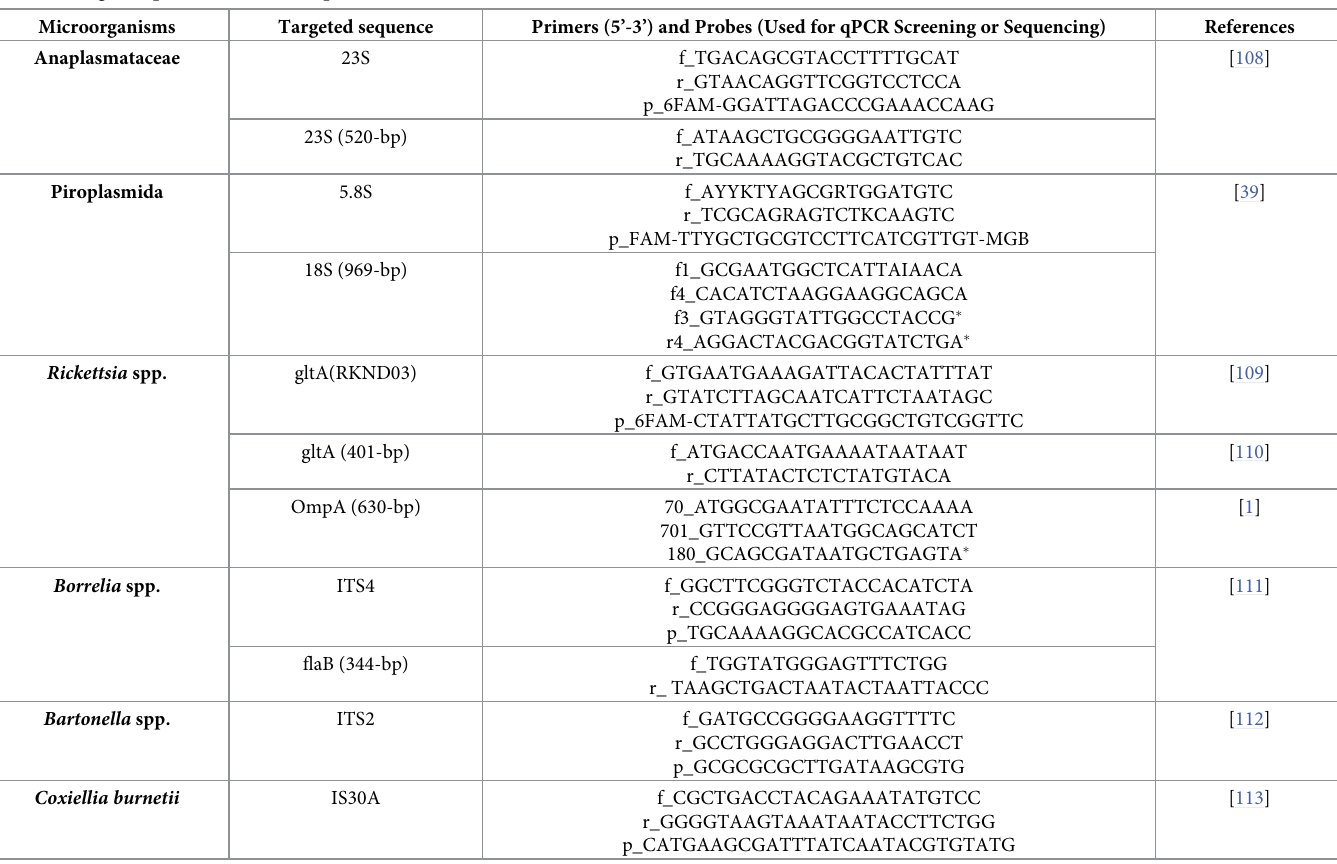
Table 1. Target amplified and used for qPCR and standard PCR.